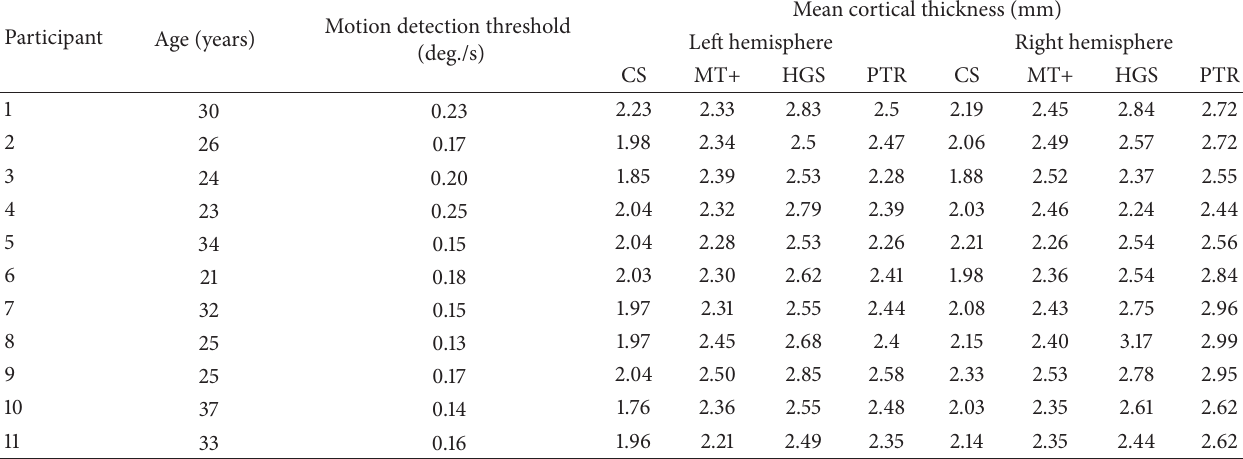
Table 1: Dataset for testing the correlation between cortical thickness and visual motion detection thresholds, controlling for participant age. Participant